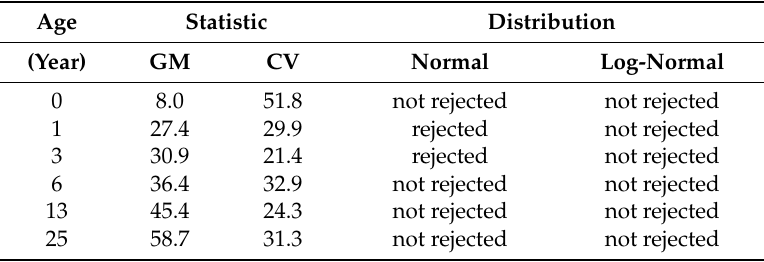
Table 3. Geometric mean, GM, and coefficient of variation, CV (%), of the saturated soil hydraulic conductivity, K s (mm h − 1 ), and results of the Kolmogorov-Smirnov test. Sample size, N = 15 for each